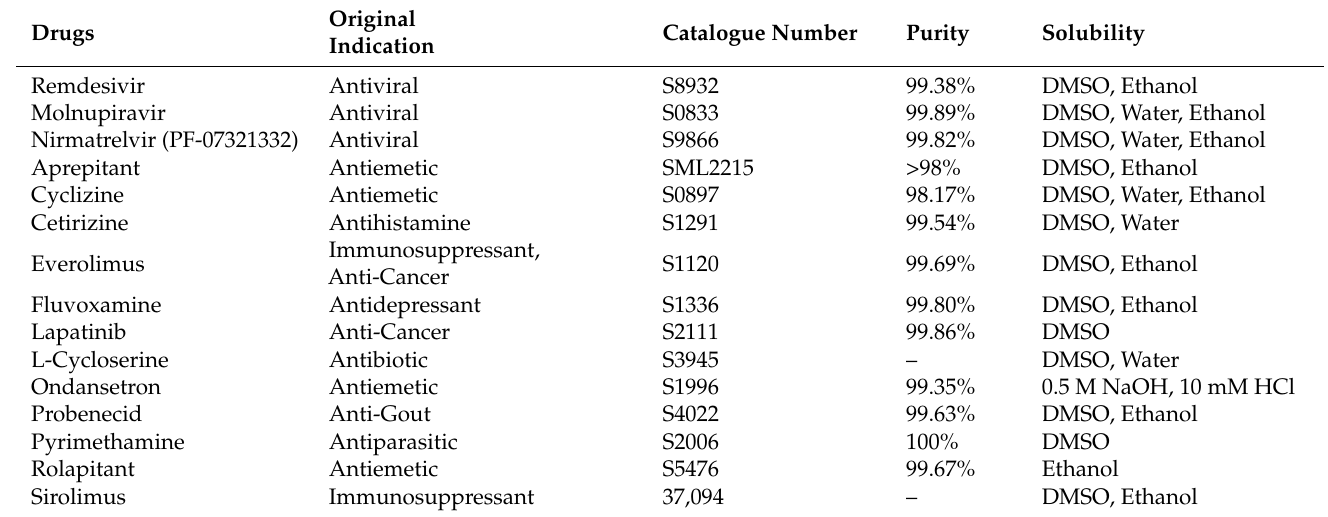
Table 1. Test Drugs and Control Drugs Used in this